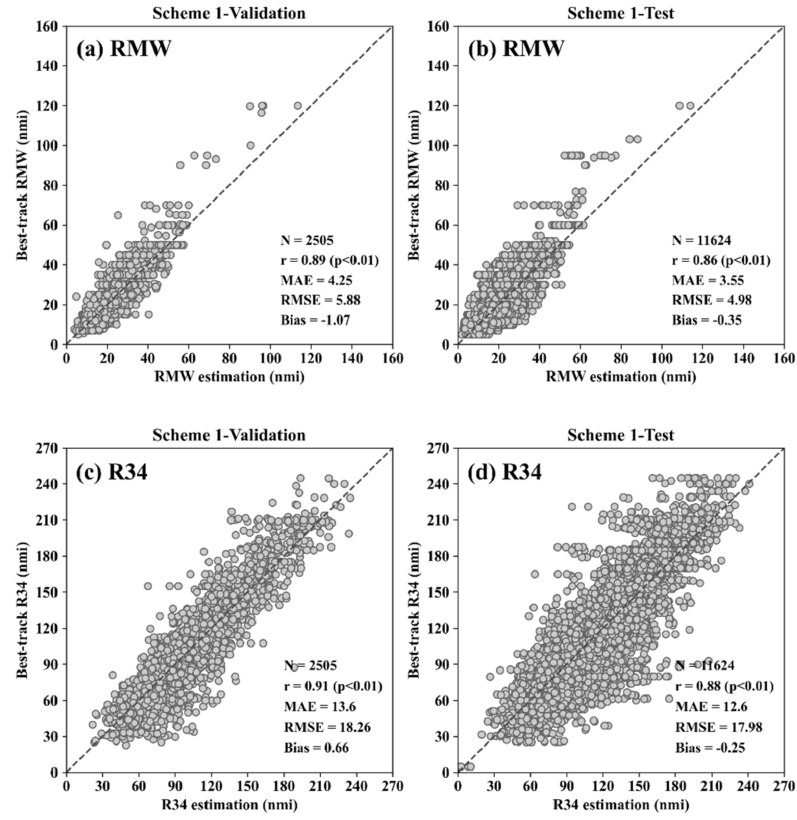
Figure 5. Validation ( a , c ) and test ( b , d ) results of the RMW and R34 estimated using the single-task model (Scheme 1). In each panel, the x-axis shows the RMW and R34 predicted by the model, and the y-axis shows the best-track RMW and R34 data. The validation data were used only to optimize the proposed model and were independent of the test data. The number of samples (N), correlation coefficient (r) and p -value, mean absolute error (MAE), root mean square error (RMSE), and bias are presented in the bottom-right corner of each